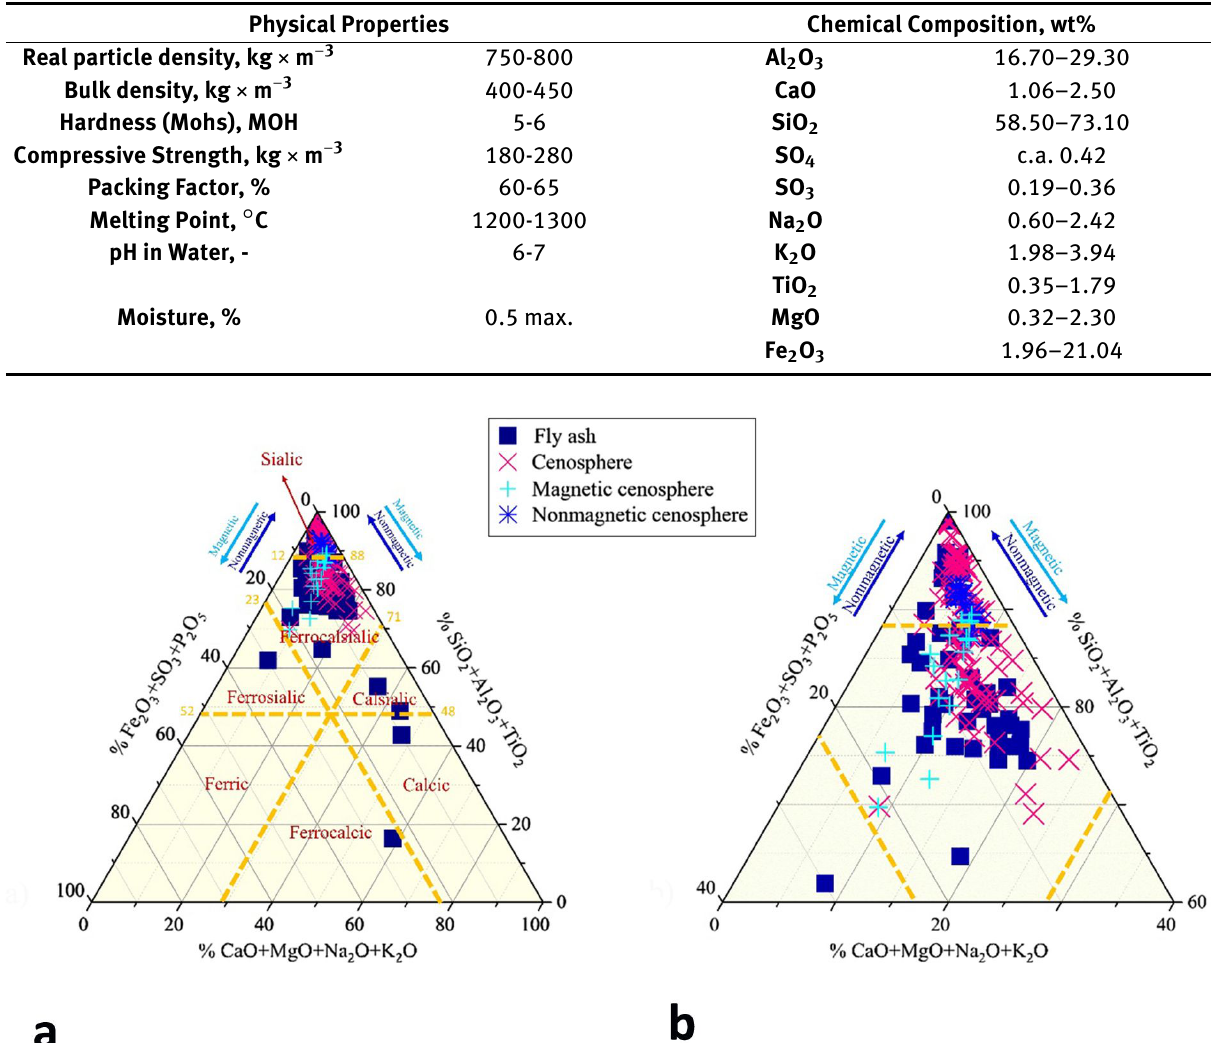
Figure 2: The ternary diagram of the chemical composition of selected fly ashes and cenospheres (Ranjbar and Kenzel); a) full diagram, b) cenospheres forming area: sialic and ferricalcsialic groups